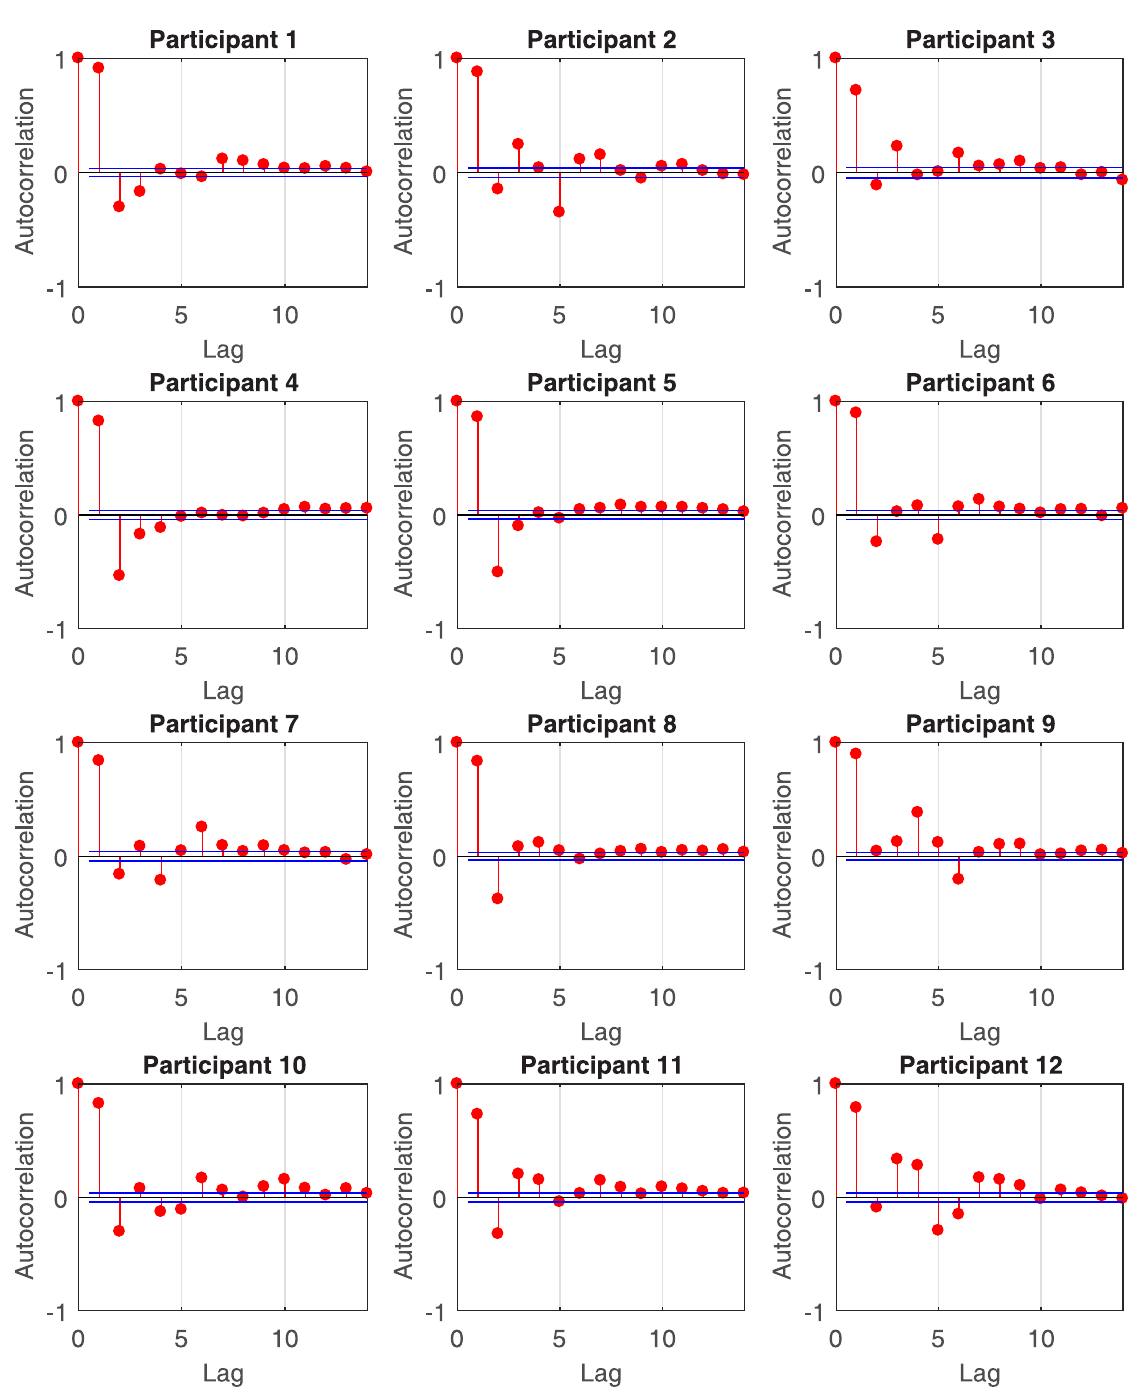
Fig 5. Partial autocorrelation analysis of RR-intervals. For all participants, the partial autocorrelation values are large at the first few lags and then become smaller. For many participants, the dependence of the current RR-interval on a lag of beyond eight is small. Consequently, we chose to investigate model orders q = 1, 2, ... , 8 for each participant and selected the value of q giving rise to the smallest KS distance.